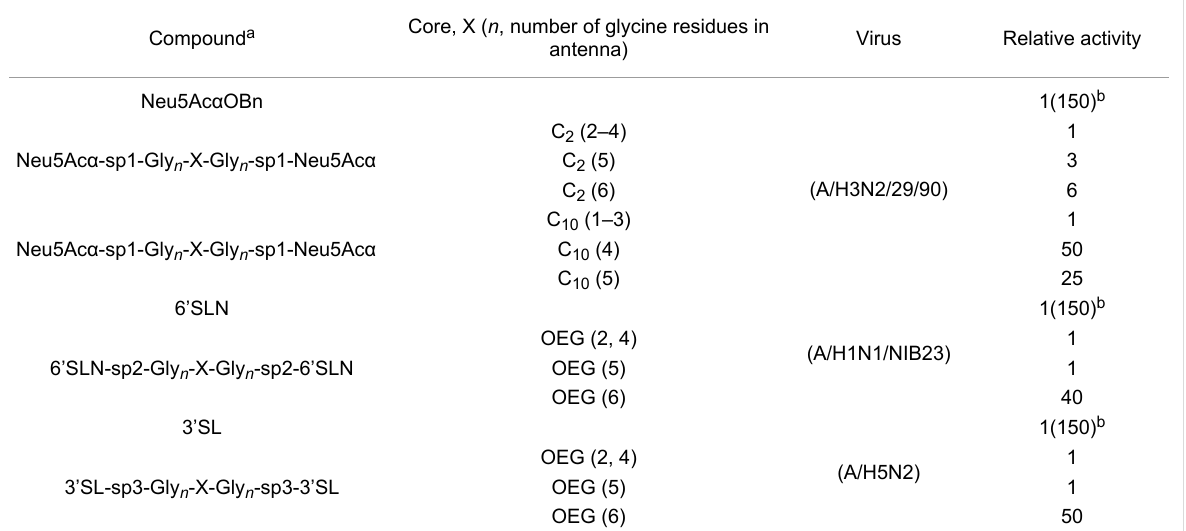
Virus Relative activity